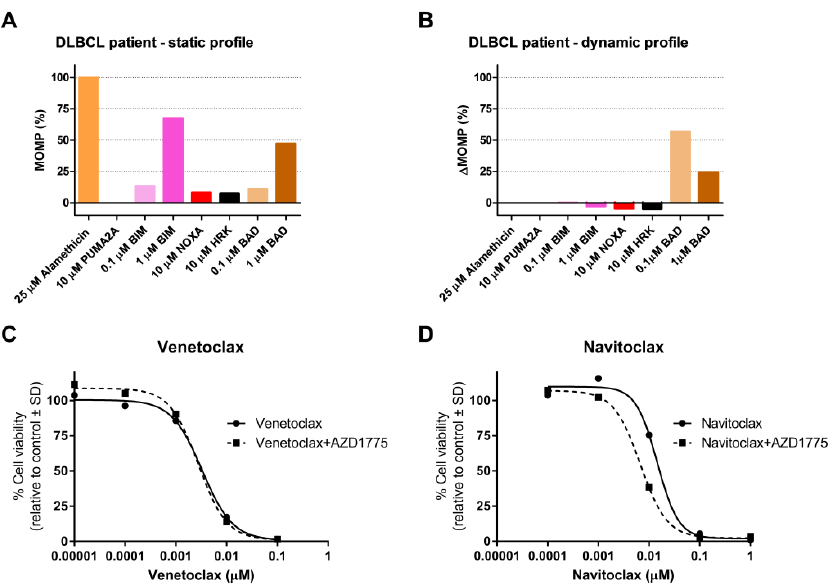
Figure 5. Dynamic BH3 profile and validation experiments in a DLBCL patient treated with AZD1775. ( A ) Static BH3 profile and ( B ) dynamic BH3 profile of DLBCL patient cells treated with 0.5 µ